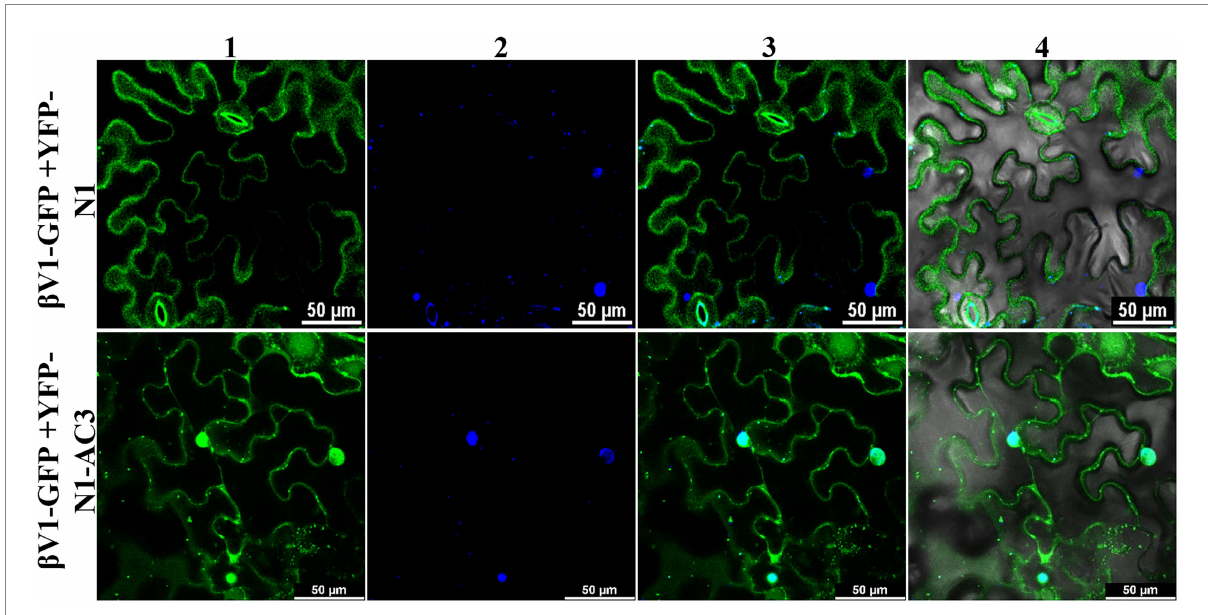
FIGURE 6 Co-expression of β V1-GFP and YFP-N1-AC3 fusion proteins. N. benthamiana leaves were agroinfiltrated with either β V1-GFP+YFP-N1 (upper row) or β V1-GFP+YFP-N1-AC3 (lower row). Epidermal cells were visualized under confocal microscopy at 48 h post infiltration. Column 1 represents the localization of β V1-GFP in the presence and absence of AC3 fusion protein. Column 2 indicates the nucleus stained with DAPI, while columns 3 and 4 represent merged images. Scale bars are equal to 50 μ